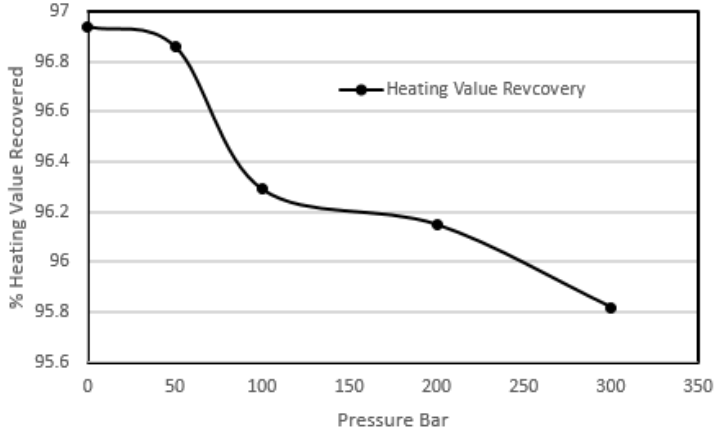
Figure 3. Effect of pressure on heating value recovery of KMnO4 desulphurised coal.